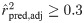
Replication of exome variant.rs28929474 is a missense variant on chromosome 14 in gene SERPINA1, low-frequency (MAF = 2.3%), imputed summary statistics (PSSimp = 1.06×−13), replication in the UK Biobank (PUKBB = 6.49×−78). rs112635299 has the strongest signal in this region (P = 4.21 × 10−14), but is highly correlated to rs28929474 (LD = 0.95). This figure shows three datasets: Results from the HapMap and the exome chip study, and imputed summary statistics. The top window shows HapMap P-values as orange circles and the imputed P-values (using summary statistics imputation) as solid circles, with the colour representing the imputation quality (only r^pred,adj2≥0.3 shown). The bottom window shows exome chip study results as solid, grey dots. Each dot represents the summary statistics of one variant. The x-axis shows the position (in Mb) on a ≥ 2 Mb range and the y-axis the −log10(P)-value. The horizontal line shows the P-value threshold of 10−6 (dotted) and 10−8 (dashed). Top and bottom window have annotated summary statistics: In the bottom window we mark dots as black if it is are part of the 122 reported hits of [13]. In the top window we mark the rs-id of variants that are part of the 122 reported variants of [13] in bold black, and if they are part of the 697 variants of [12] in bold orange font. Variants that are black (plain) are imputed variants (that had the lowest conditional P-value). Variants in orange (plain) are HapMap variants, but were not among the 697 reported hits. Each of the annotated variants is marked for clarity with a bold circle in the respective colour. The genes annotated in the middle window are printed in grey if the gene has a length < 5′000 bp or is an unrecognised gene (RP-).